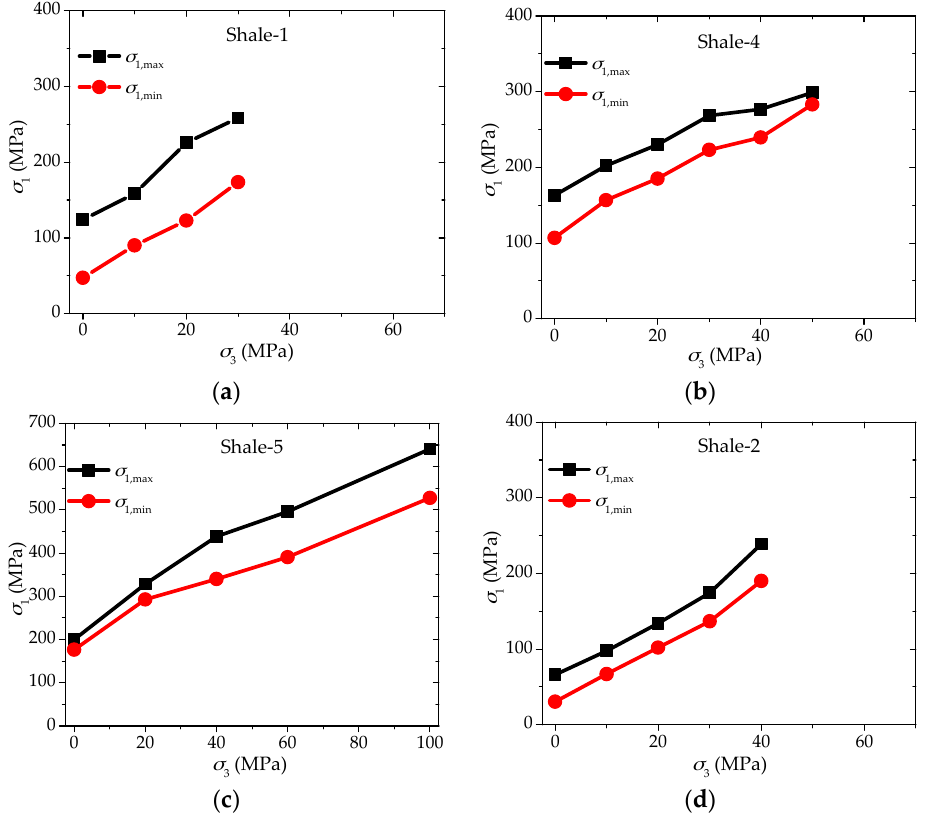
Figure 14. Four typical behaviors of maximum and minimum strengths with increasing confinement based on laboratory experimental results of ( a ) Shale-1; ( b ) Shale-4; ( c ) Shale-5; and ( d ) Shale-2 .